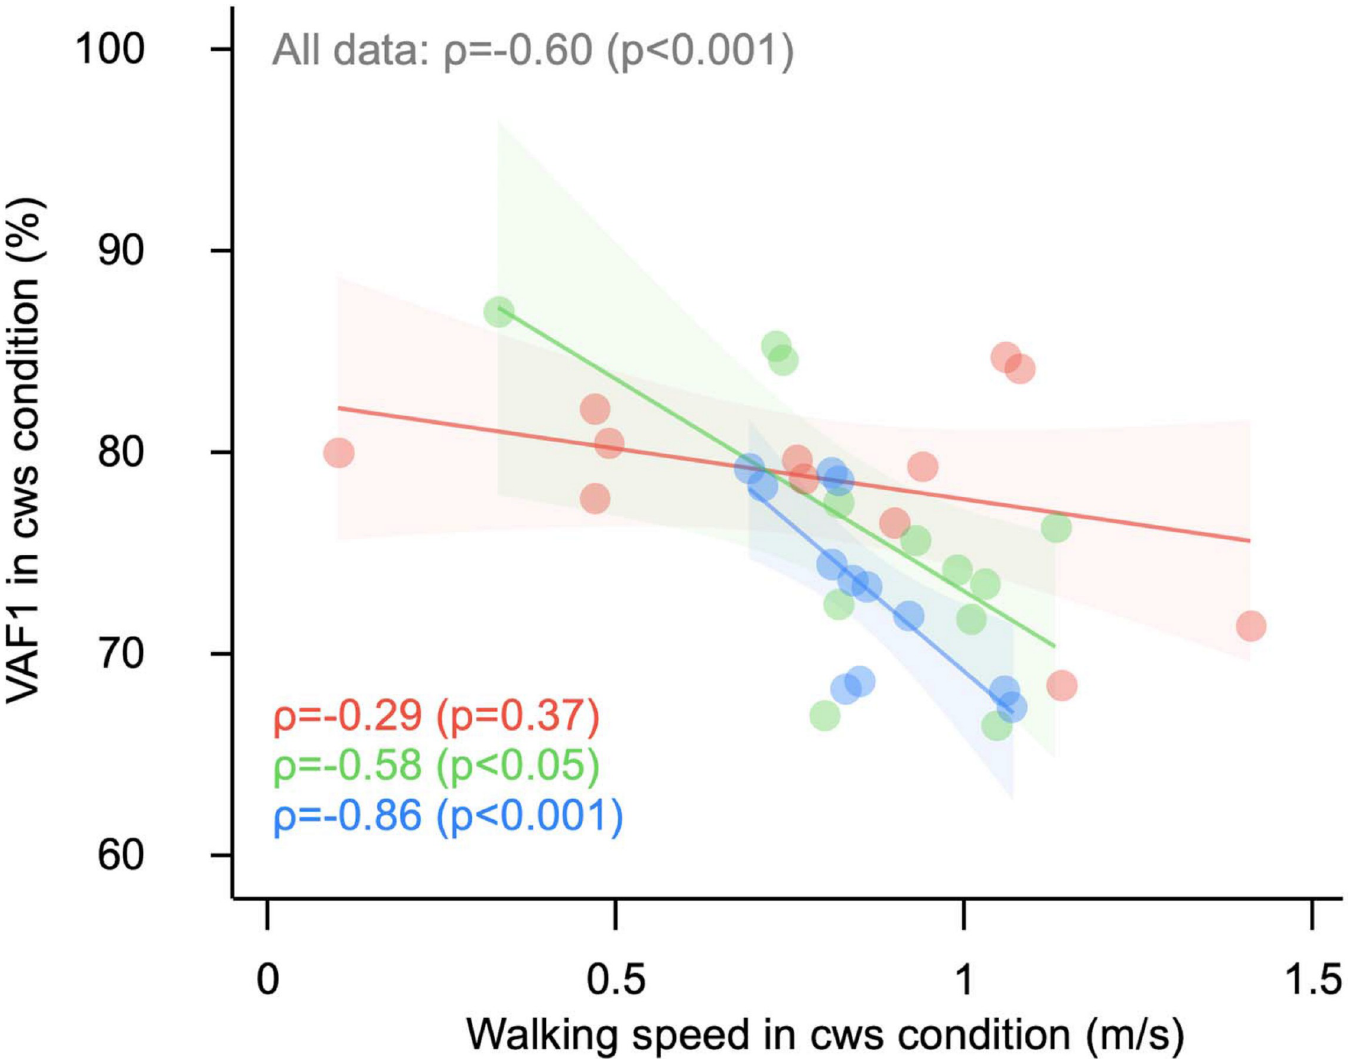
Fig 3. Association between walking speed and VAF1. The distribution shows the walking speed and VAF1 in each subtype. The line plot is a regression line and the shaded region indicates the 95% confidence interval. The top and right sides show the density plots for each subtype. Although walking speed and VAF1 showed a significant negative association, this was confirmed only for subtypes 2 and 3. Abbreviations: cws, comfortable walking speed; p-long, paralytic side long step; np-long, non-paralytic side long step; VAF, variance-accounted-for.